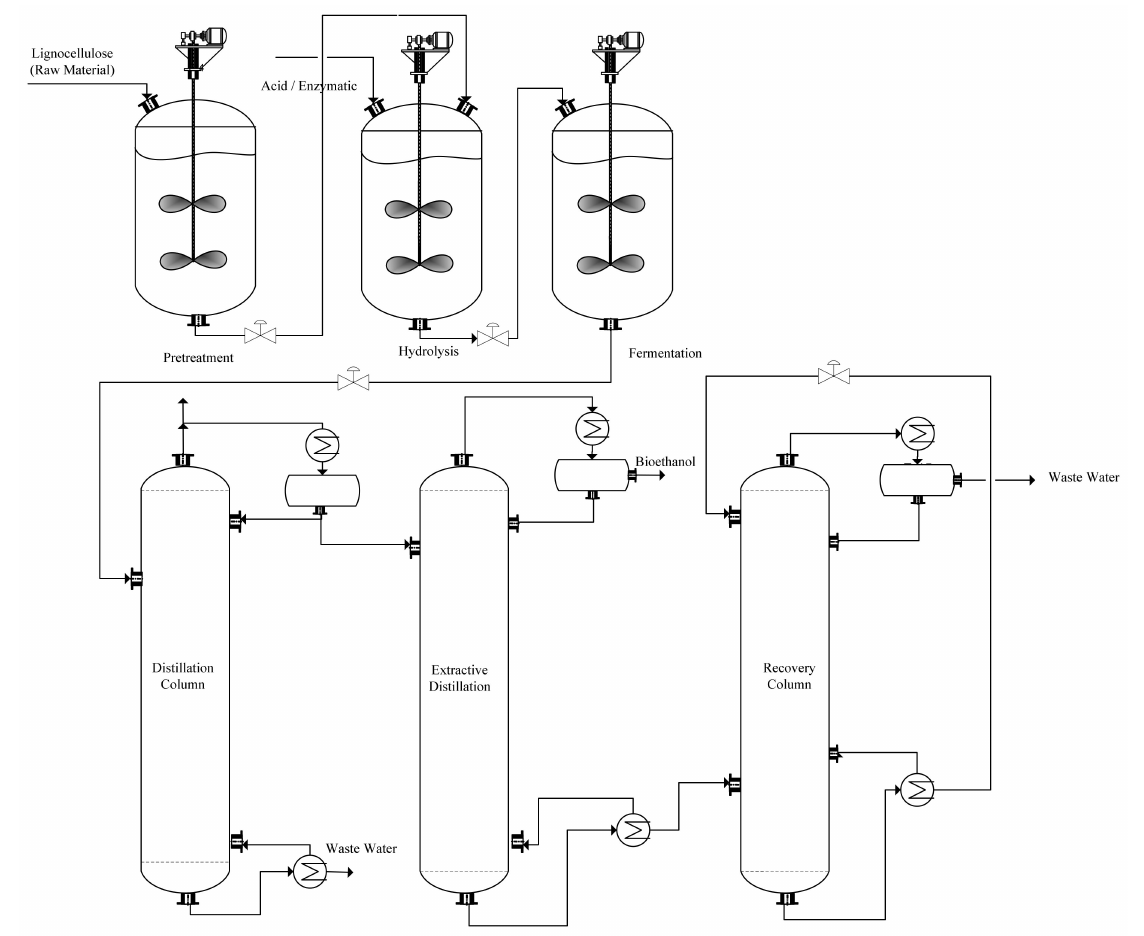
Figure 4. The separation process of bioethanol by extractive